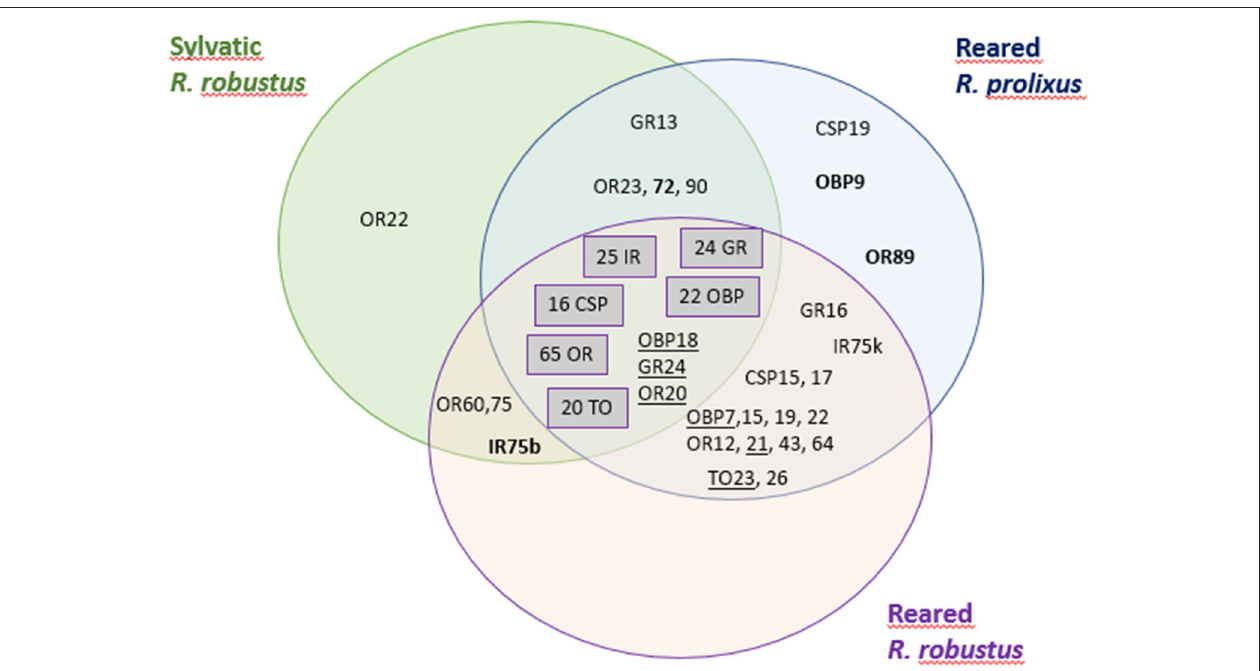
FIGURE 3 | Transcripts of interest [CSP, Odorant-binding protein (OBP), gustatory receptor (GR), odorant receptor (OR), ionotropic receptor (IR), Takeout (TO)] were detected according to the antennae and rostrum samples. Transcripts shared by all samples are indicated in gray boxes. Bold indicates the transcripts specifically expressed in females and underline indicates the transcripts specifically expressed in